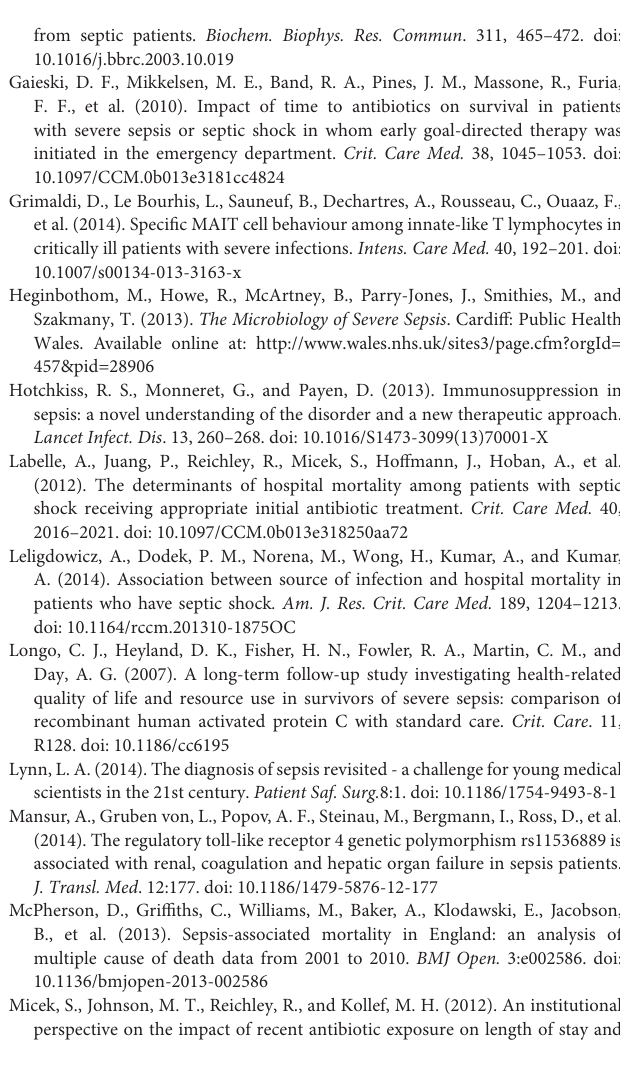
Supplementary Figure 1 | Kaplan-Meier analysis of sepsis patient survival according to Gram status of the causative organism. (A) ICNARC dataset of first-hit emergency neurosurgical patients developing a unit-acquired infection ( n = 104 ). (B) ICNARC dataset of first-hit cardiogenic shock patients developing a unit-acquired infection ( n = 56 ). None of the Gram differences are significant using the Mantel-Cox (Log-rank) test at p < 0.05